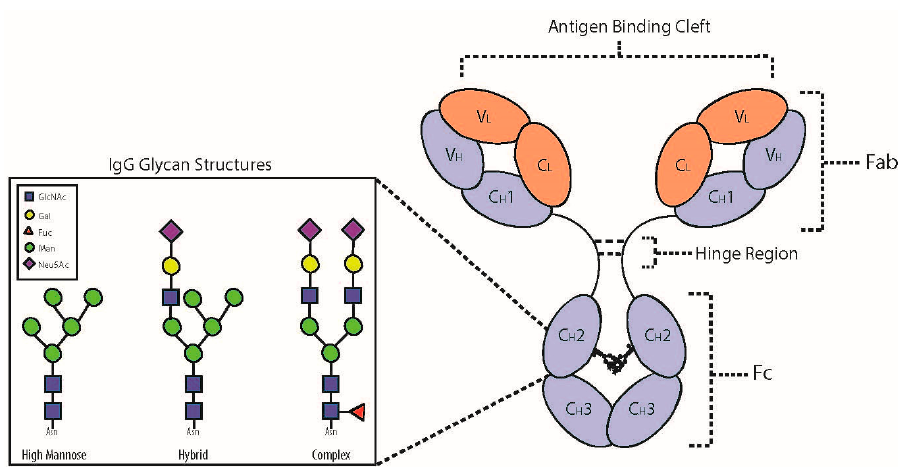
Figure 1. IgG and the associated N -glycan structures. Consisting of both heavy chains (‘ H ’) and light chains (‘ L ’), the IgG glycoprotein has two domains that infer different properties; the fragment antigen-binding (Fab) and fragment crystallisable (Fc) domains. The Fab and Fc are connected by a hinge region containing disulphide bonds, which differ depending on the IgG subclass. The Fab domain is responsible for recognising and binding antigen. The Fc domain contains two glycans attached to conserved regions of the C H 2. The Fc domain elicits effector functions by binding Fc receptors (FcRs) on natural killer and other inflammatory cells. Changes to the attached glycan moieties, simplified as the three glycan structural types in the side figure, can significantly alter effector functions of the IgG glycoprotein. GlcNAc— N -acetylglucosamine. Gal—galactose, Fuc—core fucose,